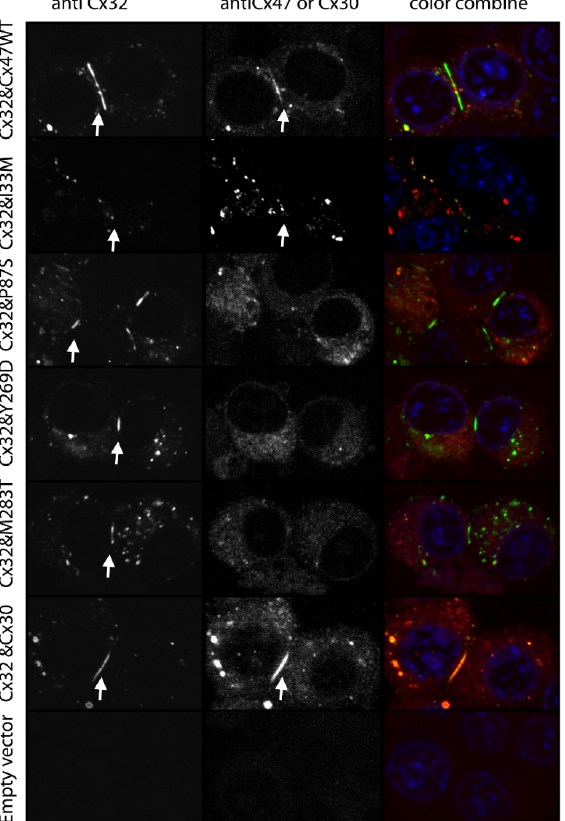
Figure 3. Examples of images used for determination of colocalization as summarized in Figure 2. Arrows show selected plaques for Cx30WT, Cx32WT, Cx47WT and Cx47I33M. A few non-junctional areas in Cx32+Cx47WT and Cx32+Cx47I33M expressing cells show overlap between staining